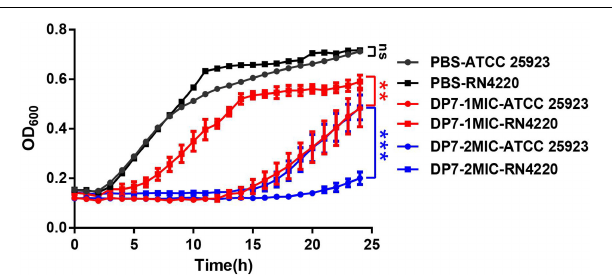
FIGURE 5 | The growth inhibition rates of DP7 in S. aureus RN4220 were lower than in S. aureus ATCC 25923. Cells were cultured at 37 ◦ C with aeration using a Bioscreen C automated growth analysis system ( n = 3). In this study, the OD values were recorded every 3 min, and the hourly OD values are plotted in this figure. ∗∗ p < 0.01; ∗∗∗ p < 0.001.